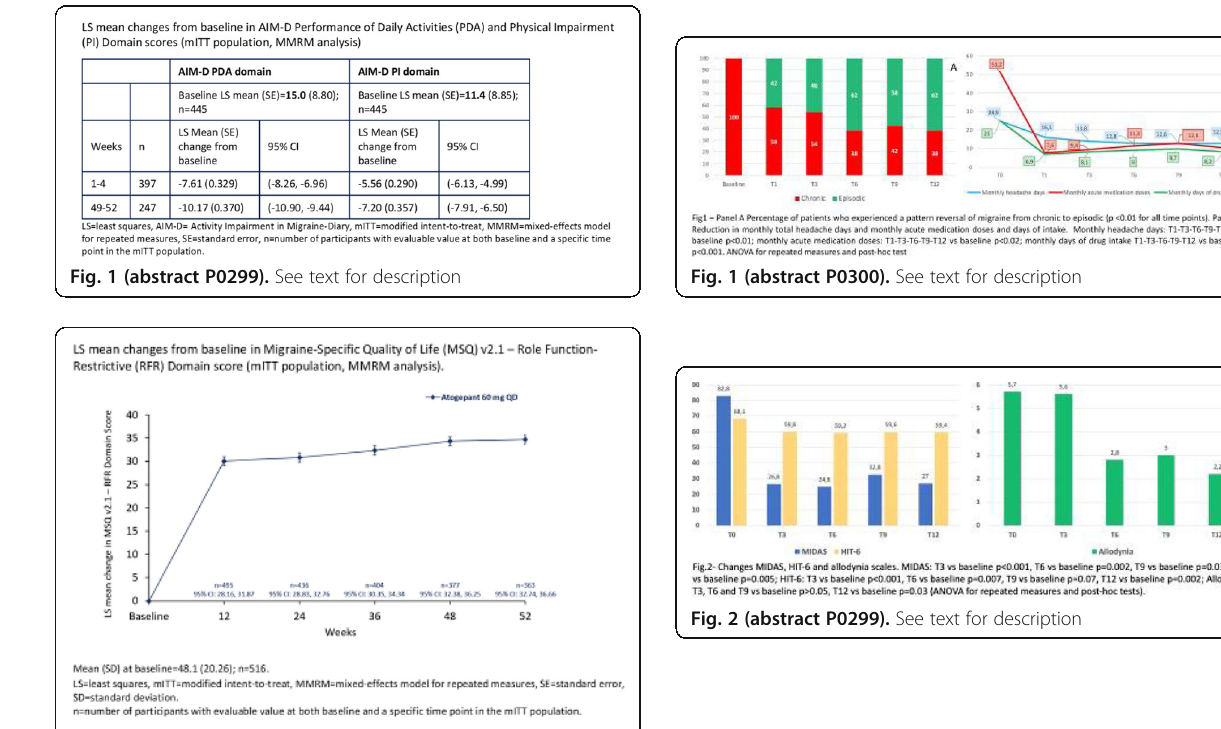
Fig. 2 (abstract P0299). See text for description